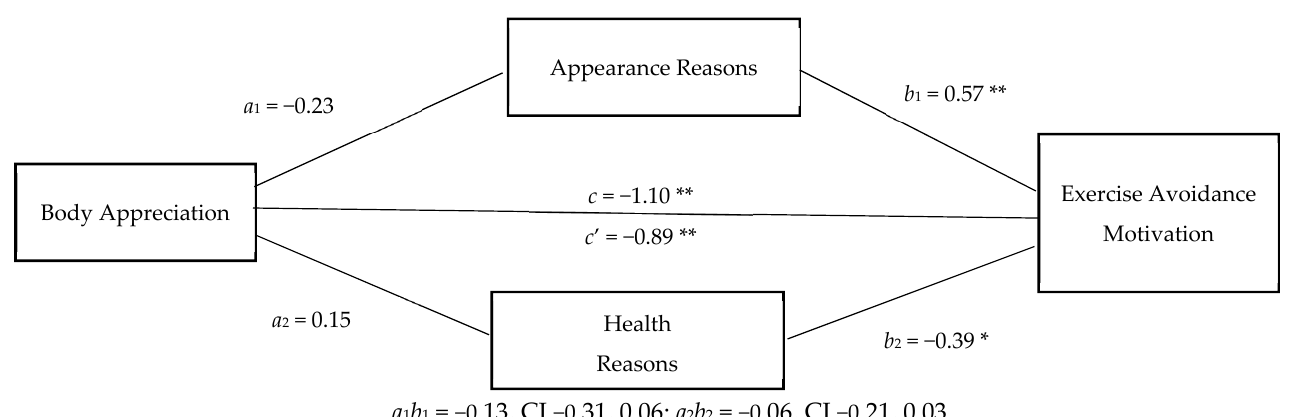
Figure 2. Appearance and Health Reasons for Exercise as Mediators of the Body Appreciation–Exercise Avoidance Motivation Relationship. * p < .05, ** p < .001.